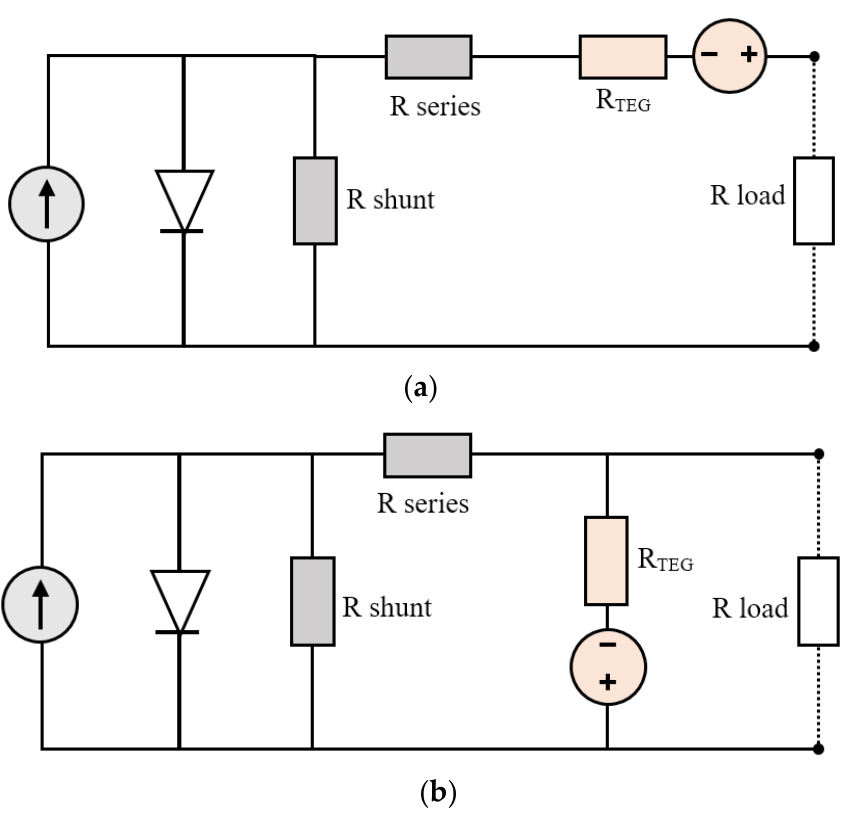
Figure 3. Equivalent circuit of an electrically connected PV-TEG in ( a ) series and ( b ) parallel.